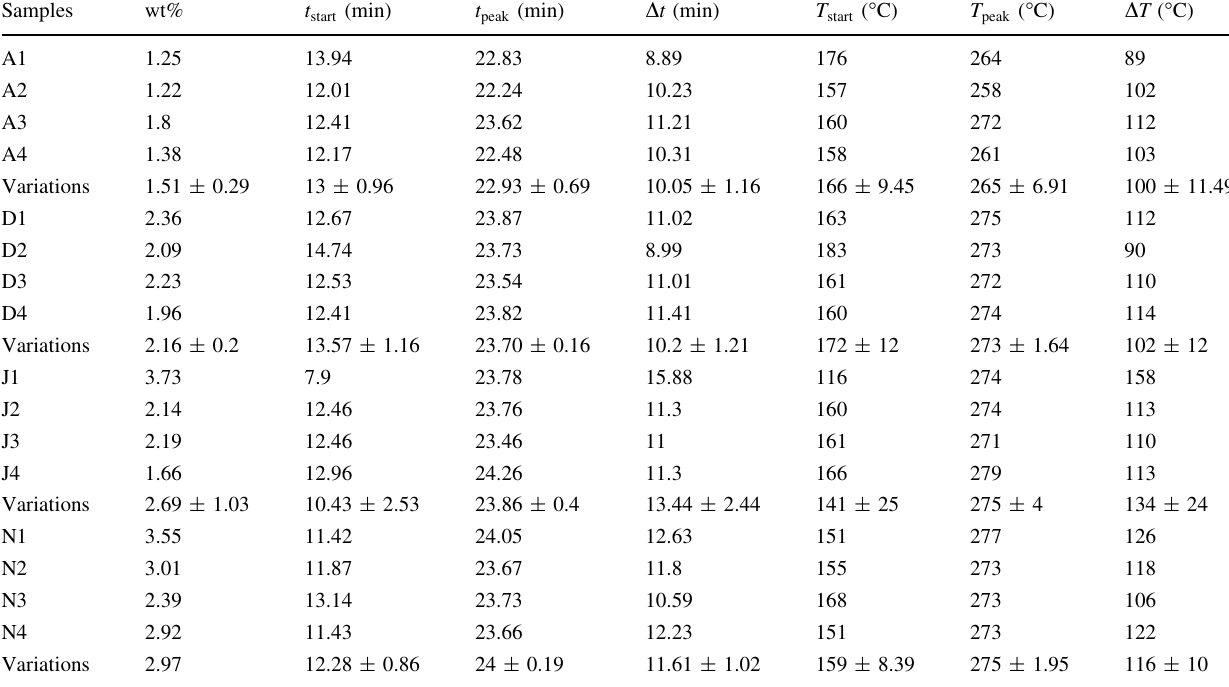
Table 6 Weight gains and characteristic temperatures of coal